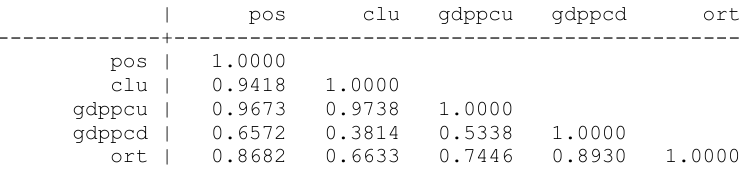
Figure 6. Cross-correlation matrix of parameters pos , clu , gdppcu , gdppcd , and ort